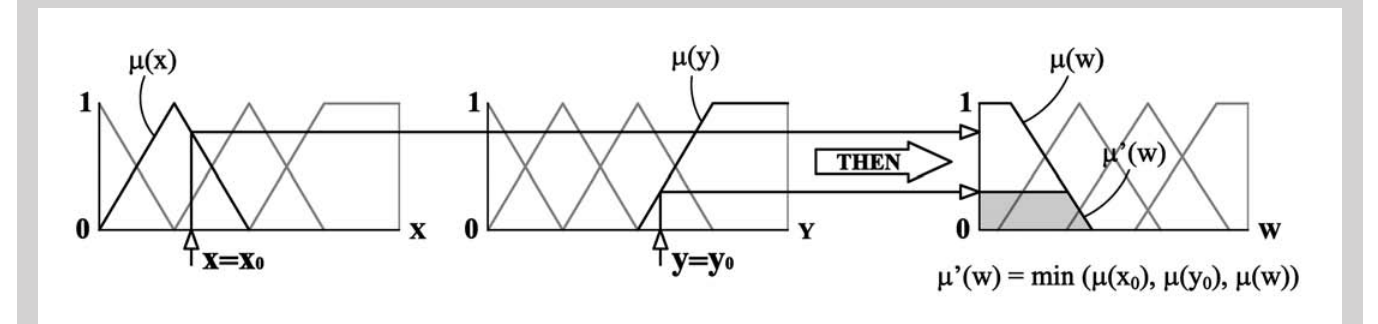
Figure 2 (below): Graphical illustration of determination of m ’(w) by min